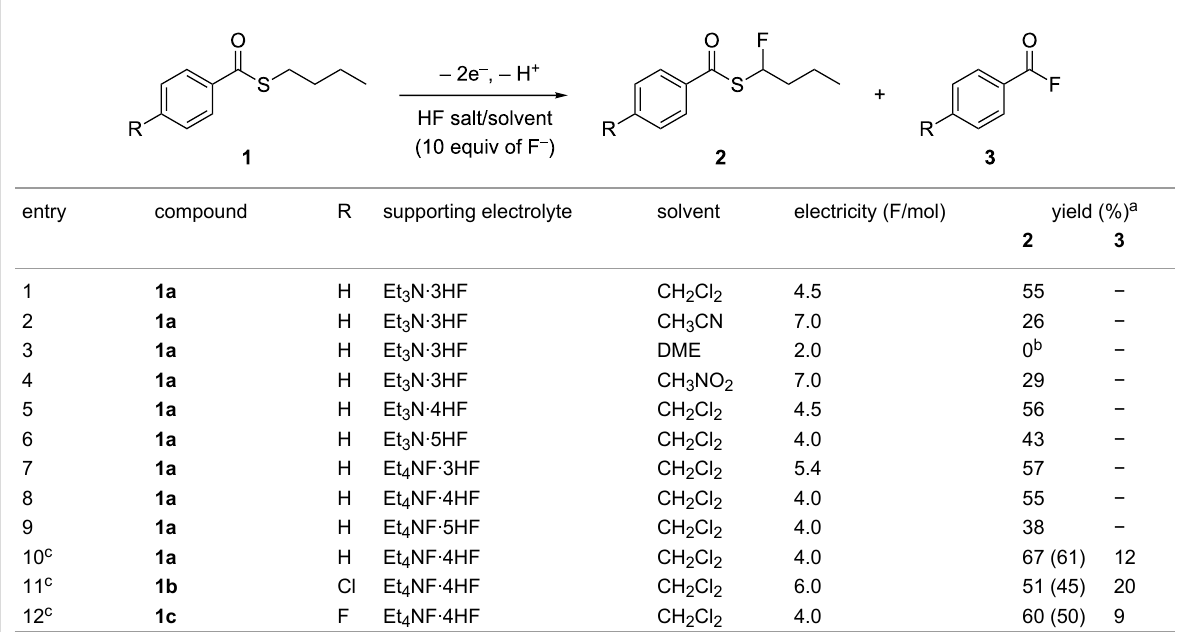
Table 1: Electrochemical fluorination of S -butyl benzothioate